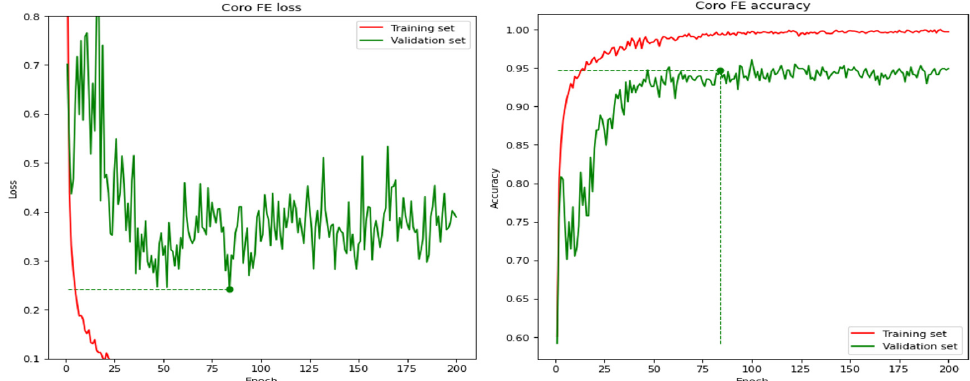
Figure 7. CoroNet Feature Extraction.